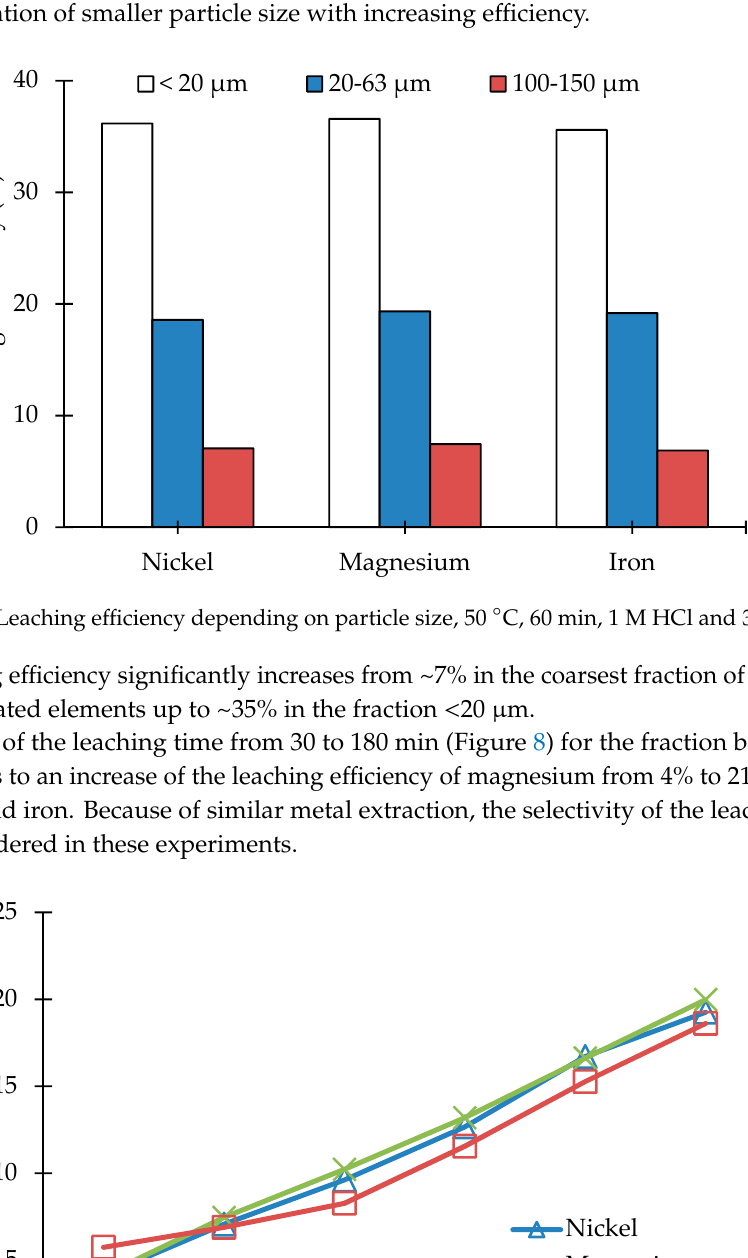
Figure 8. Leaching efficiency depending on leaching time, 100–150 µm, 50 °C, 1 M HCl and 300 rpm.